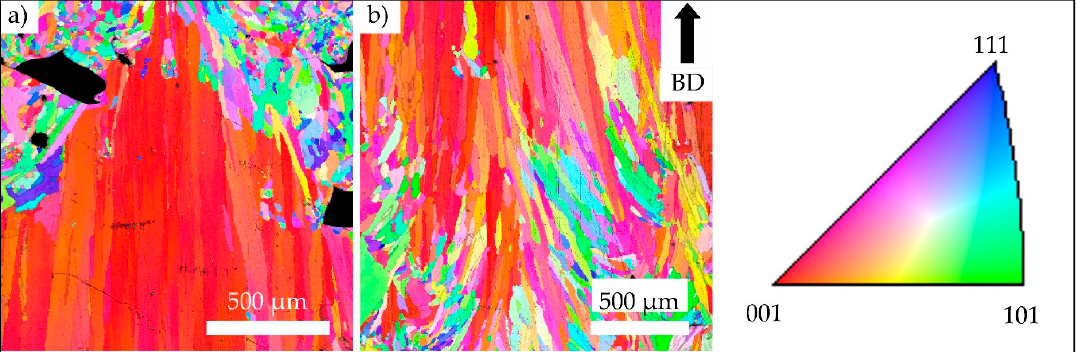
Figure 5. IPF maps plotted for BD depicting the transition areas from the lower specimen grip section to the strut with a 3 mm diameter in ( a ) and the strut to the upper specimen grip section in ( b ). Defects are colored black; color coding is according to the standard triangle shown on the right.